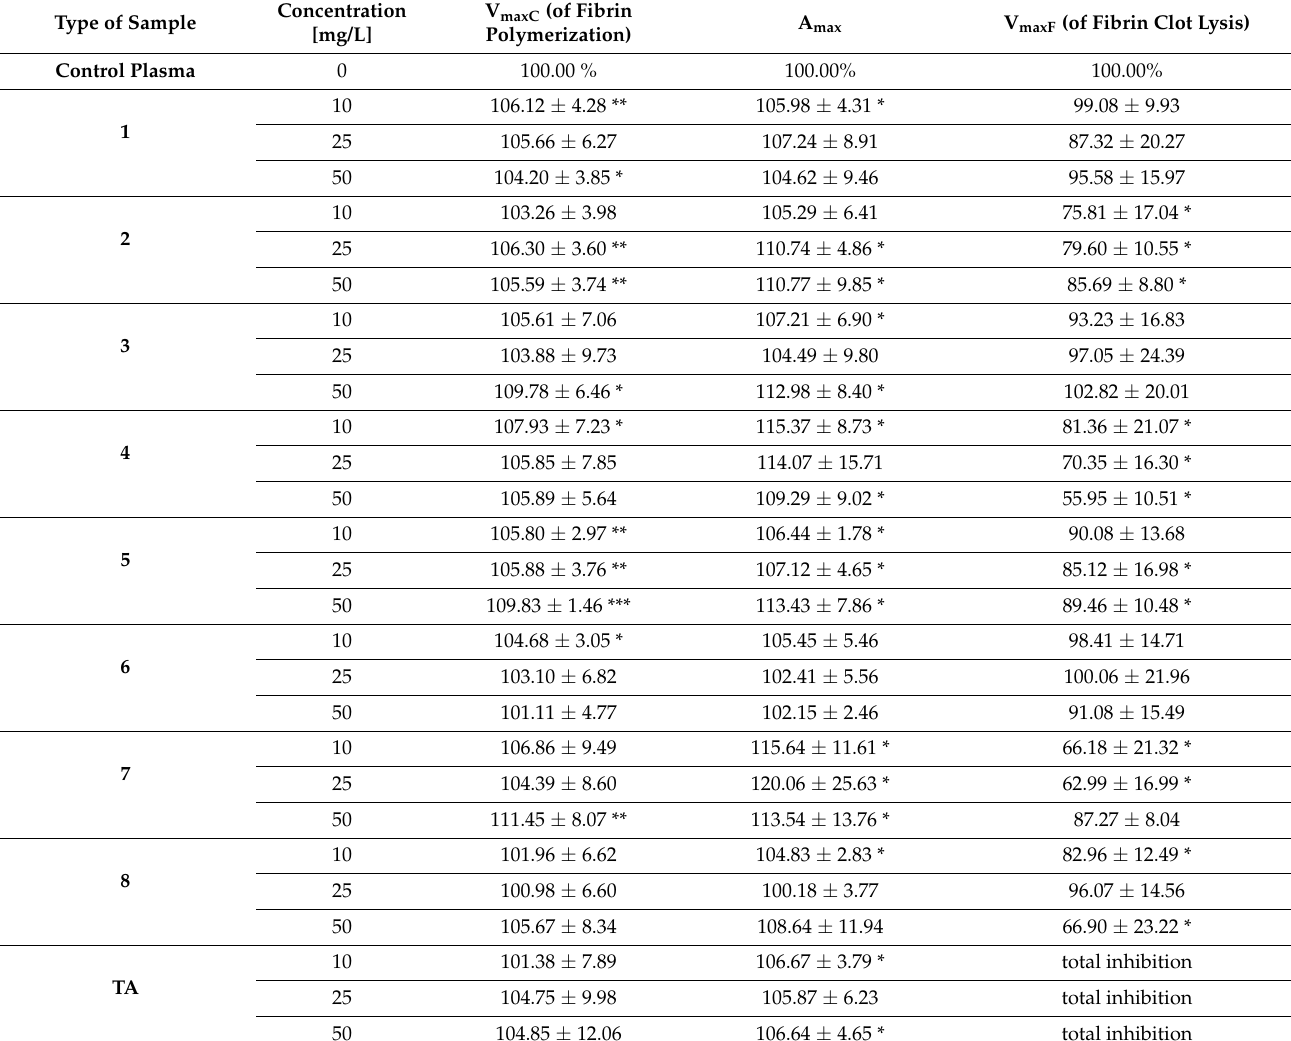
Table 1. Effects of the examined amides on the hemostatic properties of human blood plasma. The effects of each type of amide were determined in the CFF assay, based on the maximal velocity of fibrin polymerization/clotting (V maxC ), the maximum of fibrin clot absorbance at 360 nm (A max ), and the maximal velocity of fibrin clot lysis (V maxF ). The hemostatic activity of the control plasma was assumed as 100% (of V maxC , V maxF , and A max ). The results are presented as the mean ±